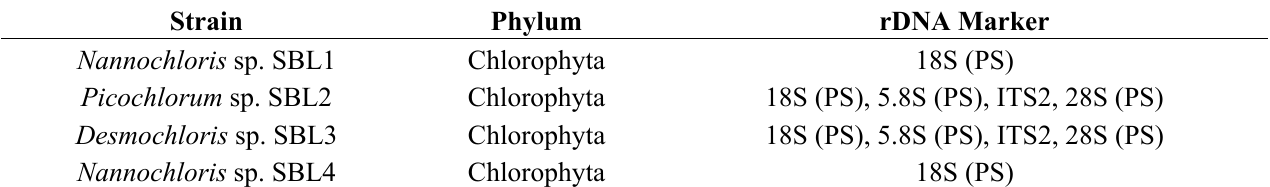
Table 1. Obtained strains, corresponding phylum and the rDNA marker used for identification of cultures acquired by FACS. PS: partial